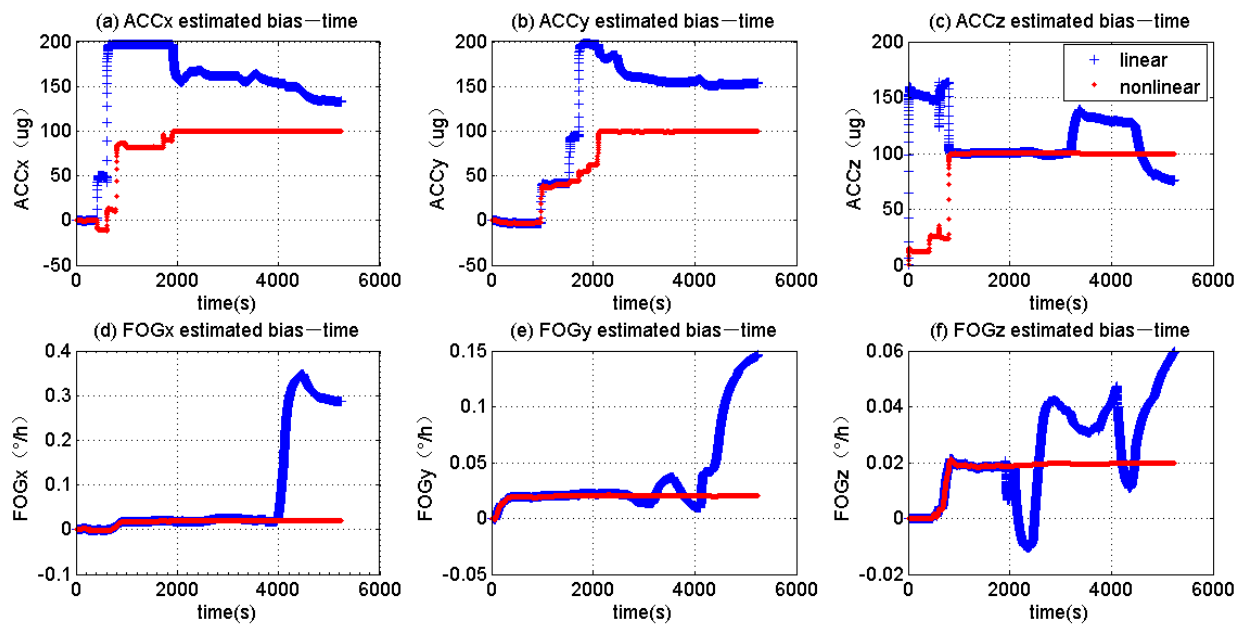
Figure 6. The estimated results of the bias error.